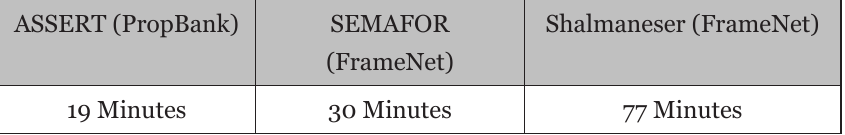
Speed Comparison between ASSERT/SEMAFOR/Shalmaneser per 1,000 Sentences ASSERT